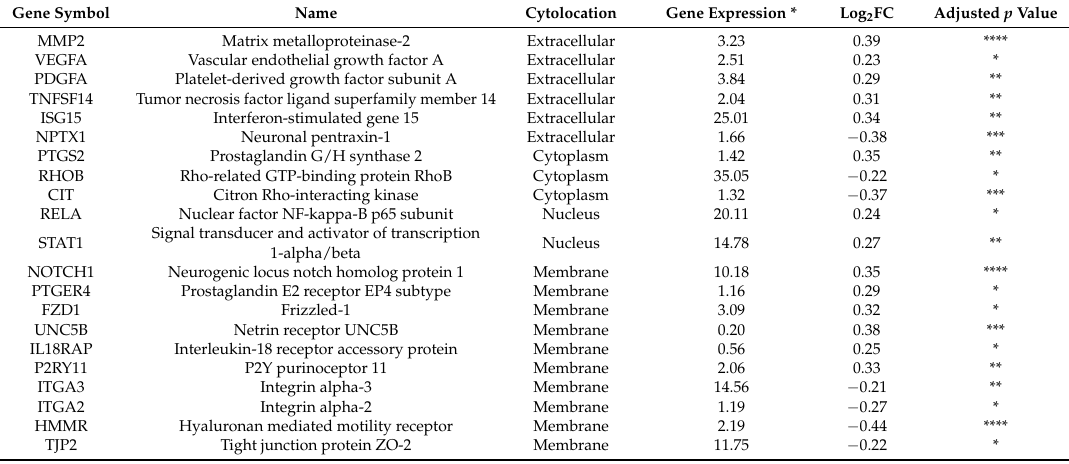
Table 2. Genes of interest in CCS versus